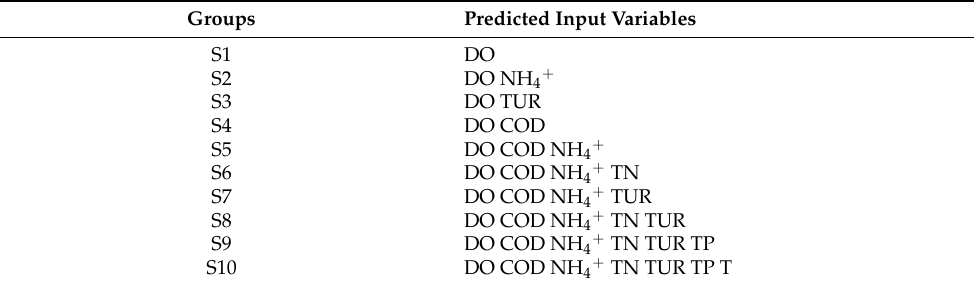
Table 6. Grouping of water quality variables based on assigned weights